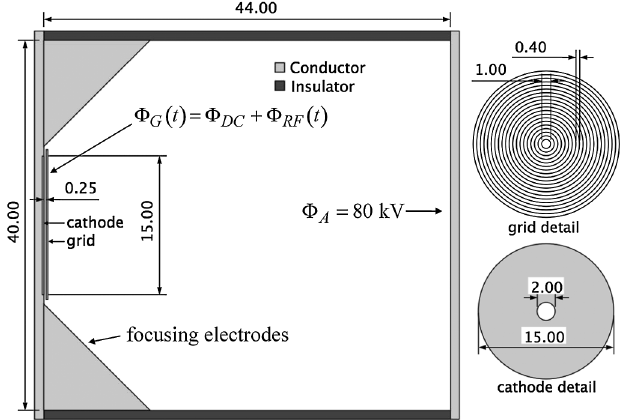
FIG. 9. Gun geometry for TURBOWAVE PIC simulations. The closed box on the left is bounded by insulators on the top and the bottom, the cathode on the left, and anode on the right. The 45 (cid:9) focusing electrodes are also shown. The cathode is grounded, the anode is at 80 kV and the grid potential consists of a dc , and a time-varying rf contribution (cid:2) contribution (cid:2) DC The cross section of the cathode and the grid are shown on the right. All dimensions are in mm.